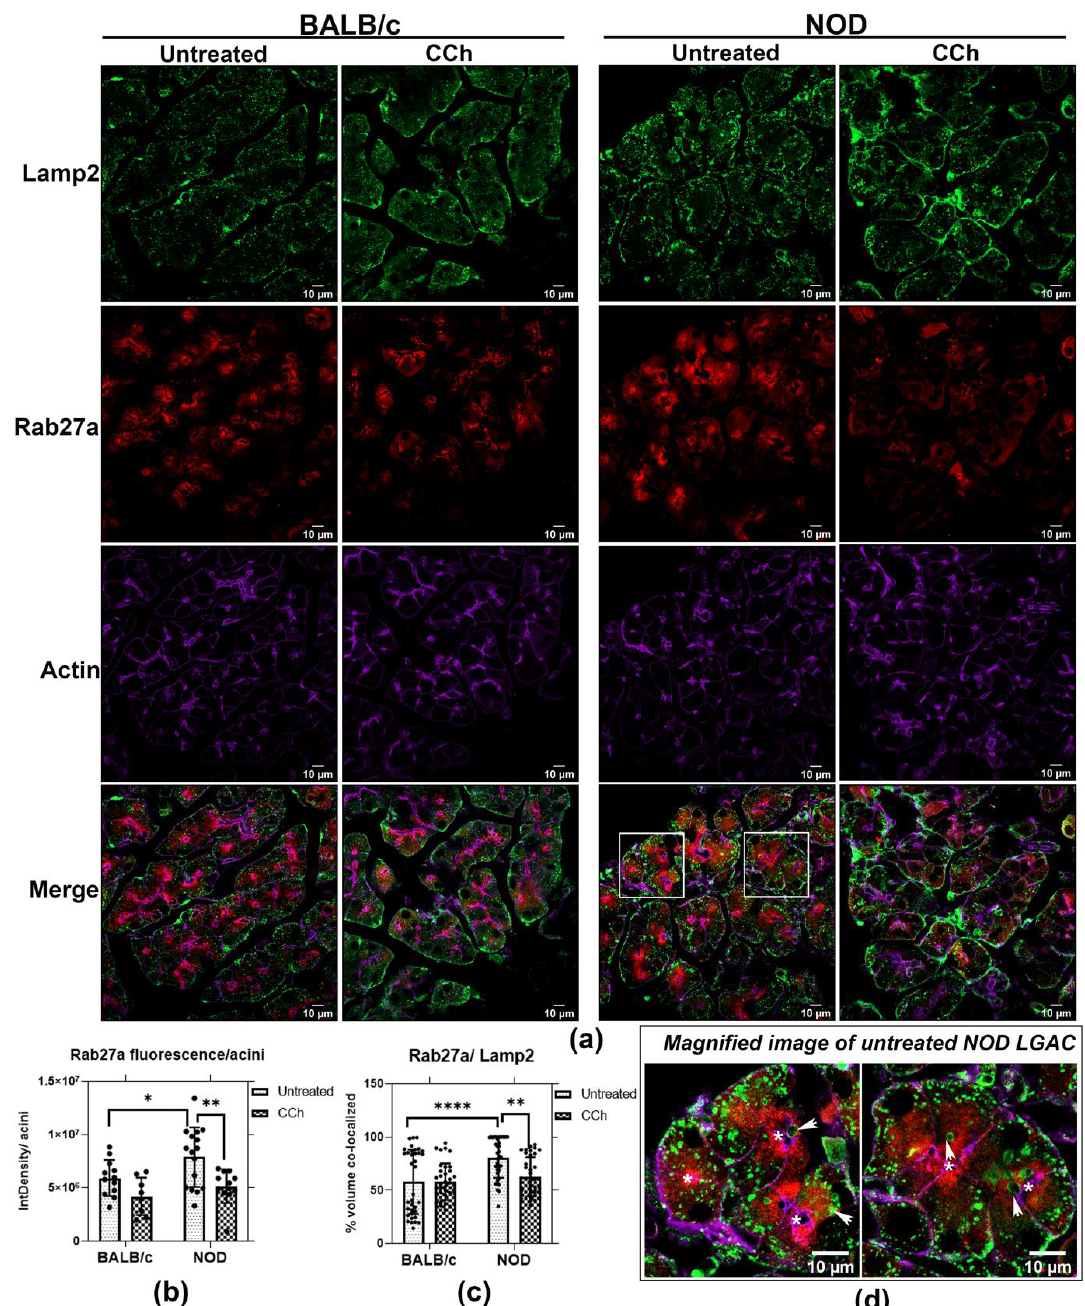
Figure 7. Rab27a enrichment with endolysosomes is increased in LG from male NOD mice. ( a ) Analysis of immunofluo- rescence by confocal fluorescence microcopy showed that the endolysosomal marker, Lamp2, was partially colocalized with Rab27a in unstimulated acini. ( b ) Upon CCh stimulation, the integrated density of Rab27a within each acinar cell was decreased, with this reduction shown to be significant in NOD mouse LG (*, p = 0.0290; **, p = 0.0040). Integrated density in three acini were quantifed and average in each field, as described previously [46]. 4 fields were obtained in each mouse section, presented as points. N = 4, N = mouse per group. ( c ) Rab27a colocalization with Lamp2 was significantly increased in unstimulated NOD mouse LG (****, p ≤ 0.0001) relative to BALB/c mouse LG, while CCh stimulation signifi- cantly reduced this colocalization in NOD mouse LG (**, p = 0.0032). ( d ) Magnified images of untreated NOD mouse LGAC demonstrated an accumulation of large Lamp2-enriched vesicles in the apical region, colocalized with Rab27a (White arrows). Colocalization was quantified in three acini per field, four fields were aquired from each mouse section. N = 4, N: mouse per group. *, Lumen.